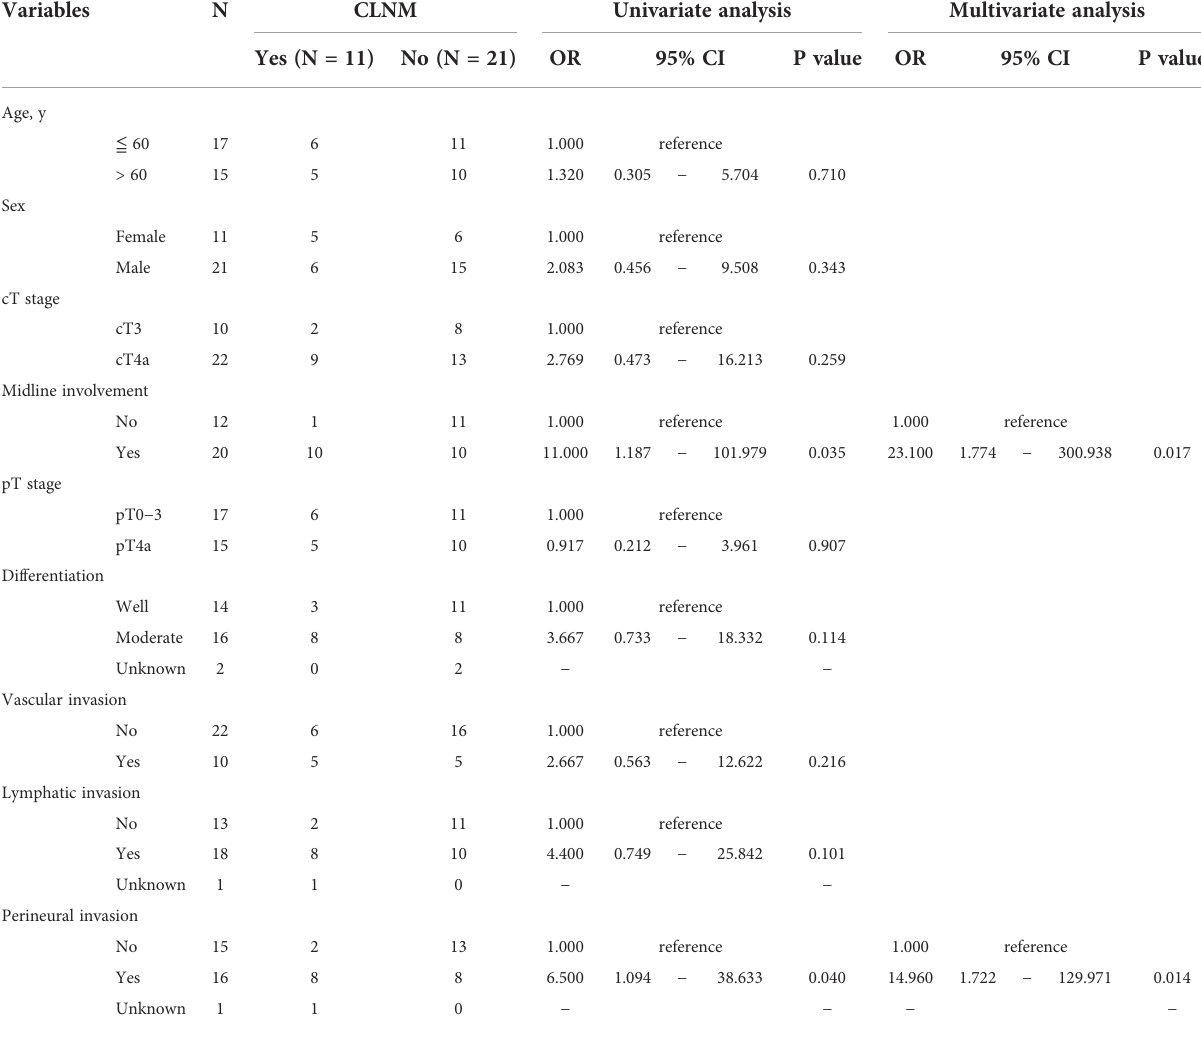
TABLE 2 Univariate and multivariate logistic regression analysis for factors affecting